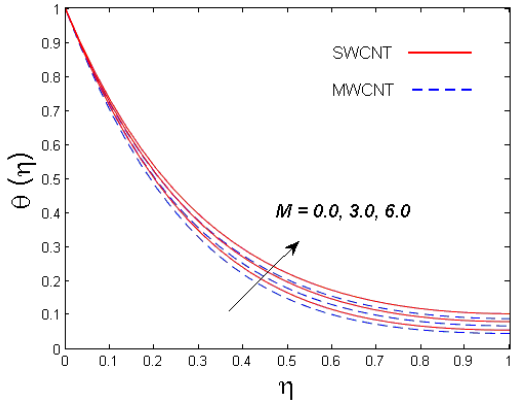
Figure 7. The illustration of M versus θ(η).